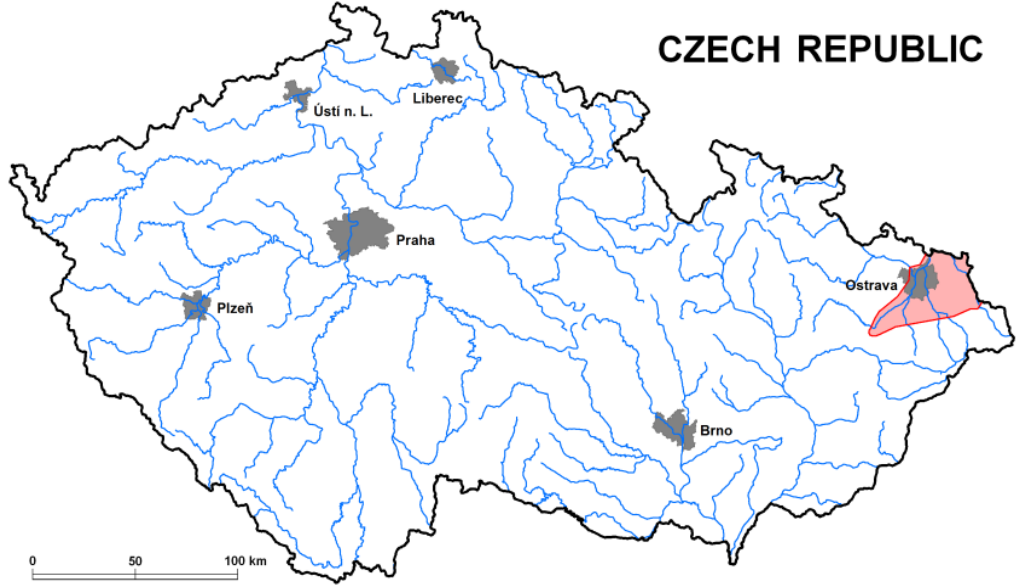
Fig. 1. Location of the concerned area in the Czech